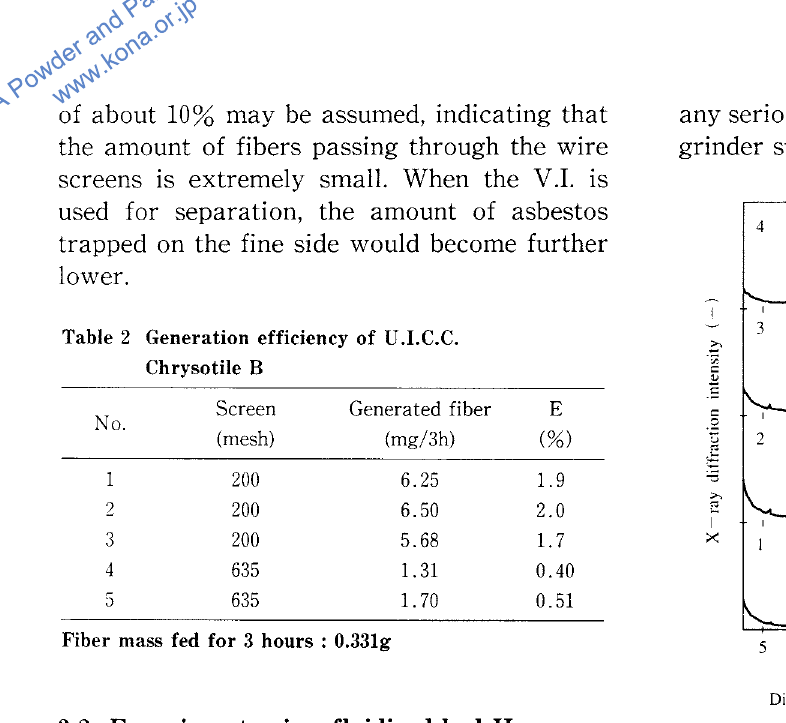
Fig. 6 X -ray diffraction pattern of Chsysotile B samples